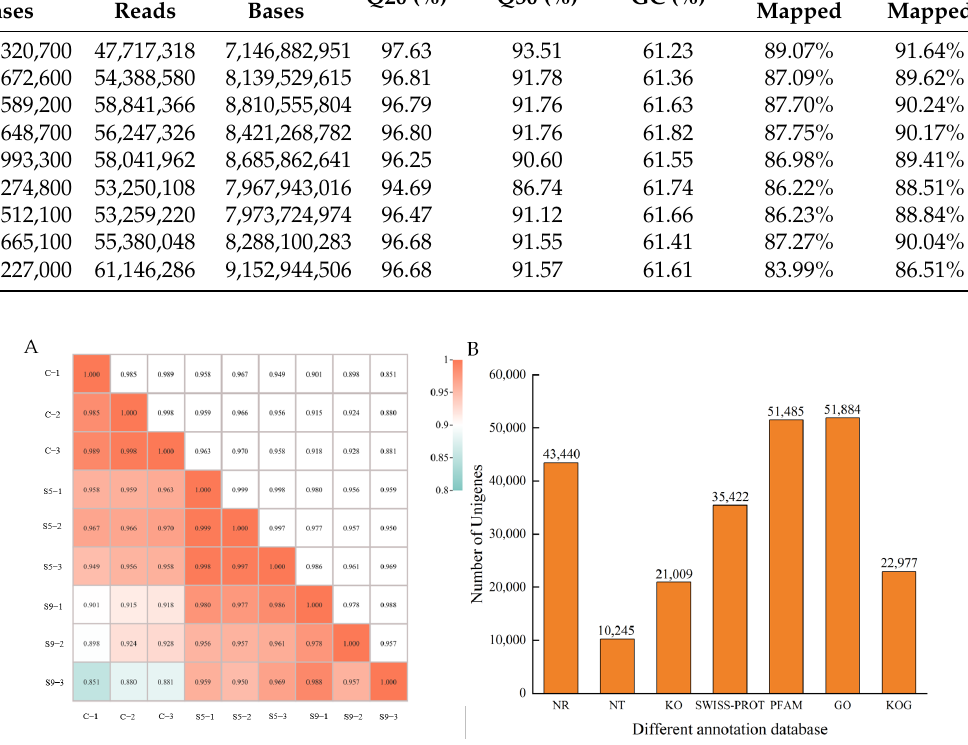
Table 2. Summary of Illumina RNA-seq data. (C: salinity 30 psu; S5: salinity 50 psu; S9: salinity 90 psu).